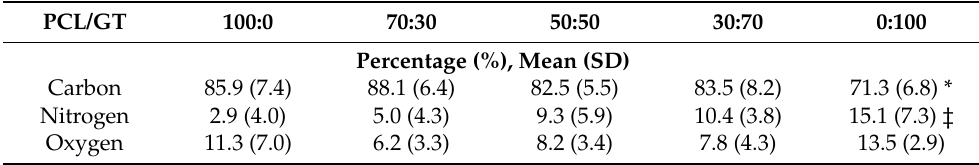
Table 1. Elemental analyses of PCL/GT nanofibers by energy dispersive X-ray spectroscopy (EDX). Two-way ANOVA with post-hoc Tukey demonstrated a significant drop of carbon percentage in PCL/GT 0:100 (pure GT) in comparison to the rest of the groups. * p -value (<0.05) compared to all